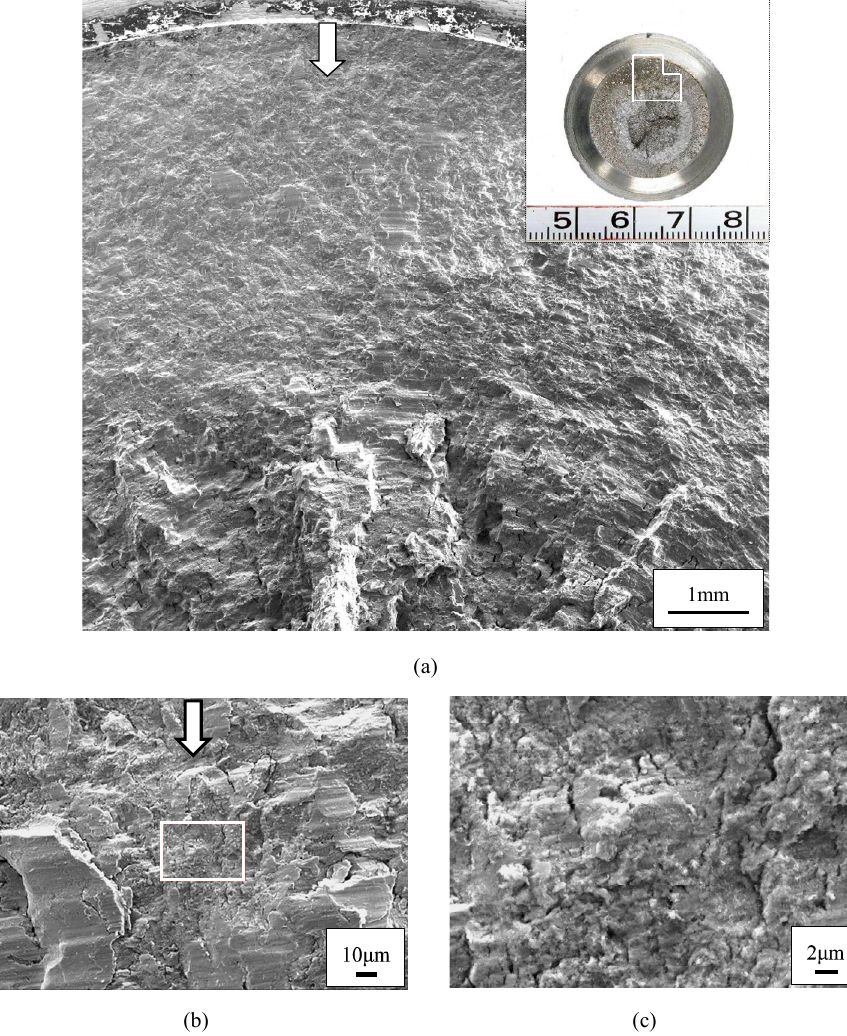
Figure 15. Fracture surface of RP3 observed using a SEM (arrows indicate the direction of the crack growth). ( a ) Macroscopic appearance of the fracture surface, ( b ) 3 mm from the notch tip ( δ = 30 ◦ ), and ( c ) an enlarged view indicated by a frame in ( b ).